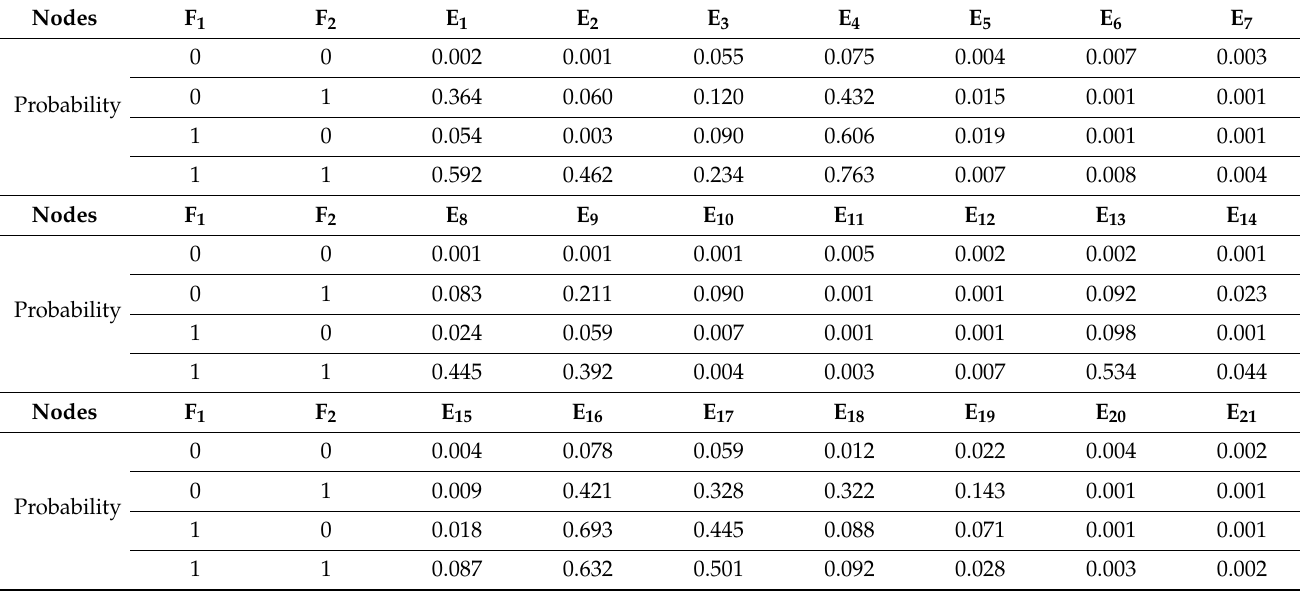
Table 4. The conditional probabilities of evidence nodes E 1 –E 21 .